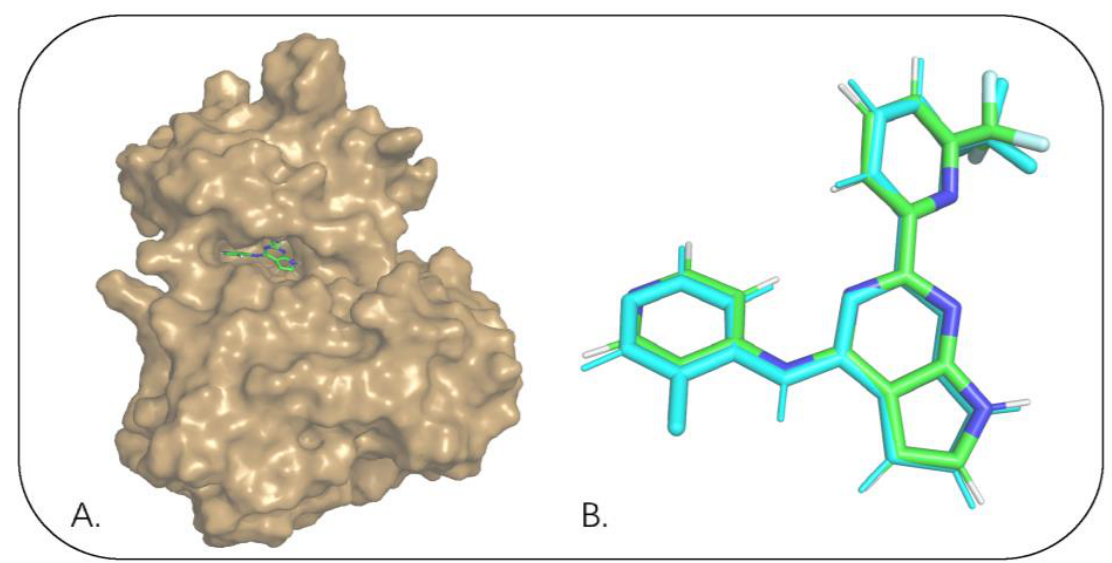
Figure 4. ( A ) The global diagram of the active pocket on the surface of TGF β RI(PDB ID: 6B8Y). ( B ) The re-docking validation: the crystal pose (Green) and re-docking pose (Cyans) of the ligand BMS22. The results of molecular docking revealed that 30 modified compounds had excellent PMF values that were higher than 112.00 comparable to the reference molecule BMS22 (PMF = 113.32), including 11 molecules from the H-series, 11 molecules from the S-series, and 8 molecules from the W-series (Table S3–1 and Table S3–2). Except for H5 and S4, which formed only two hydrogen bonds with the active pocket, the other molecules formed three or four hydrogen bonds with key residues LYS232, HIS283, ASP351, SER280, or TYR249, as confirmed by manual review and had good hydrophobic interactions with non-polar amino acids such as ILE211, VAL219, LEU260, LEU278, and ALA350. This is consistent with most TGF β RIinhibitors in the crystal structure having the same mode of